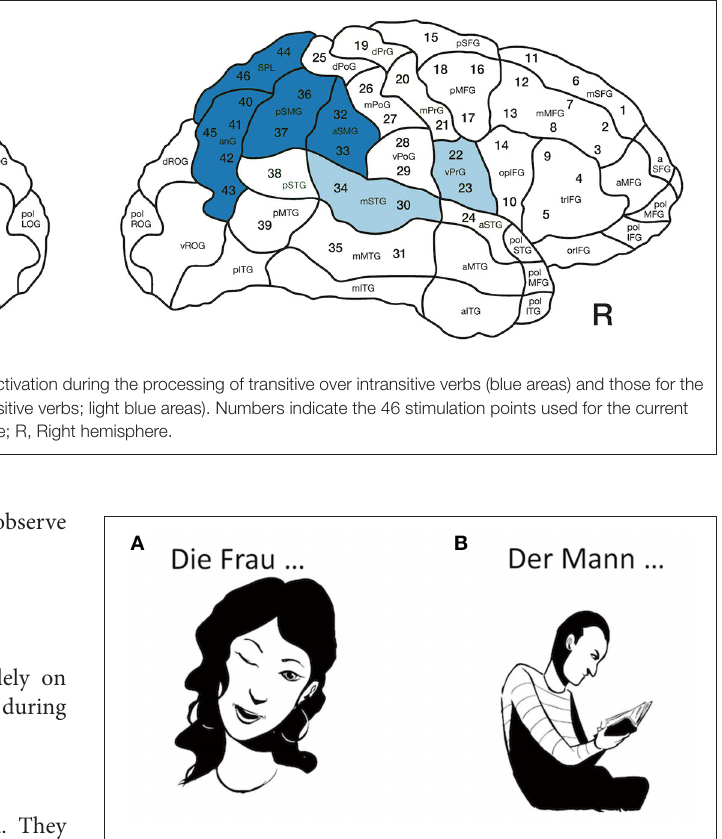
FIGURE 2 | Example of an intransitive (A) and a transitive item (B) used during nTMS language mapping. The intransitive item triggered the sentence Die Frau…zwinkert : “The woman…winks,” while the transitive item triggered the sentence Der Mann…liest : “The man…reads”. Art work by Victor Xandri Antolin. © University of